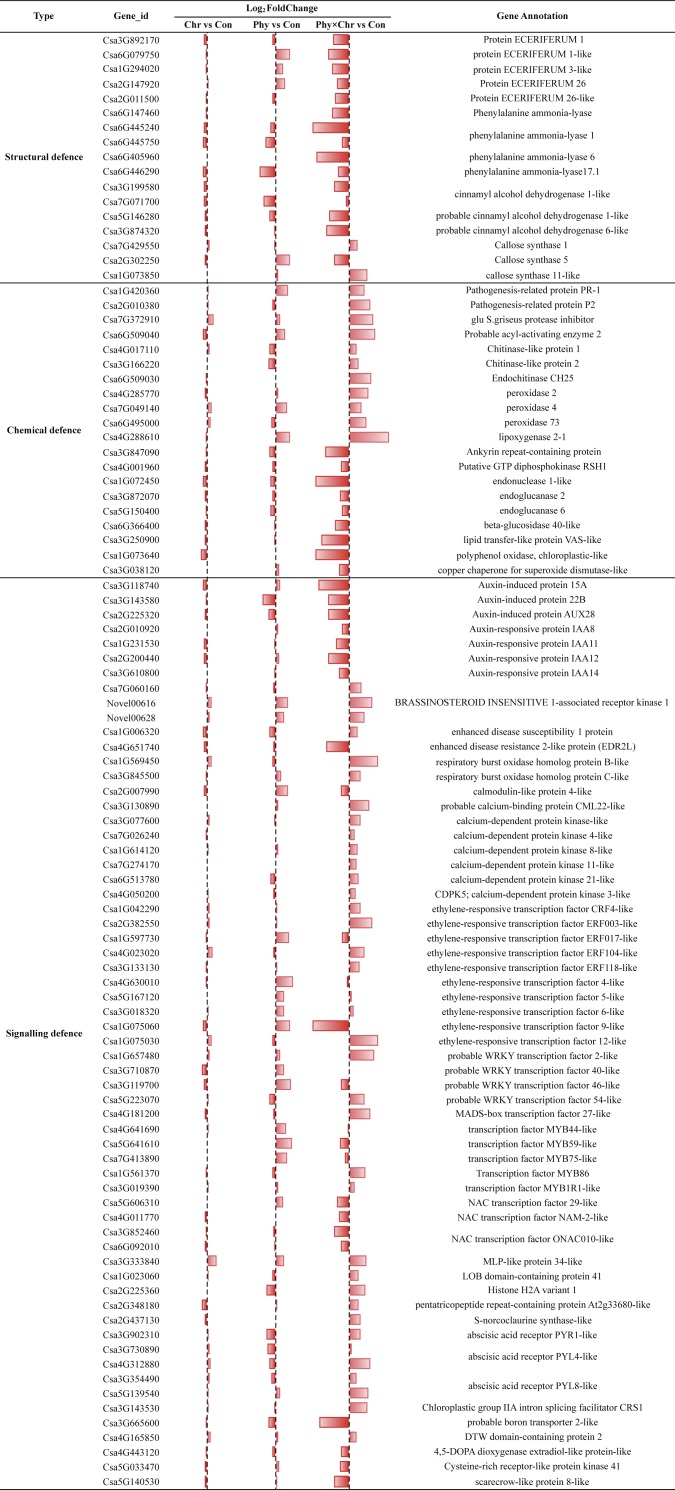
Comparison of the proportions of defense-related genes in Chr1, Phy1 and Phy × Chr vs. Con1.A bar left of the line means that the gene is down-regulated, while a bar right of the line means up-regulated.